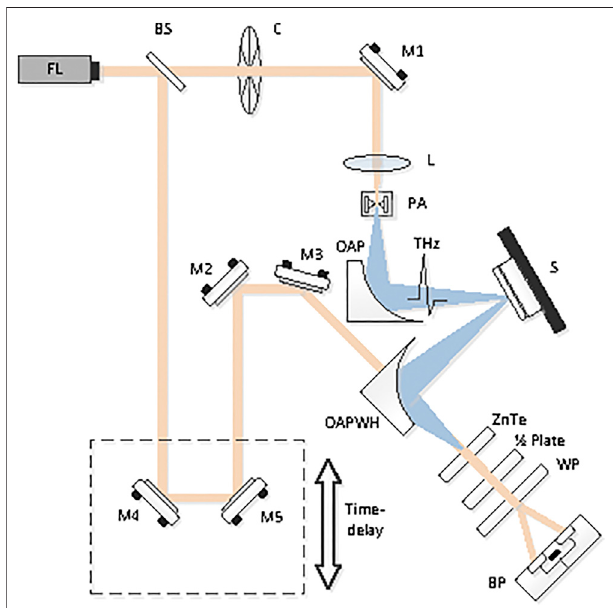
FIGURE 1 | The schematic diagram of a typical THz-TDS instrument with re fl ection mode. FL: femtosecond laser; BS: beam splitter; M1, M2, M3, M4, and M5: plane mirror; C, chopper; L, lens; PA, photoconductive antenna; OAP, off-axis parabolic mirrors; OAPWH, off-axis parabolic mirror with hole; WP, Wollaston prism; BP, balanced ampli fi cation